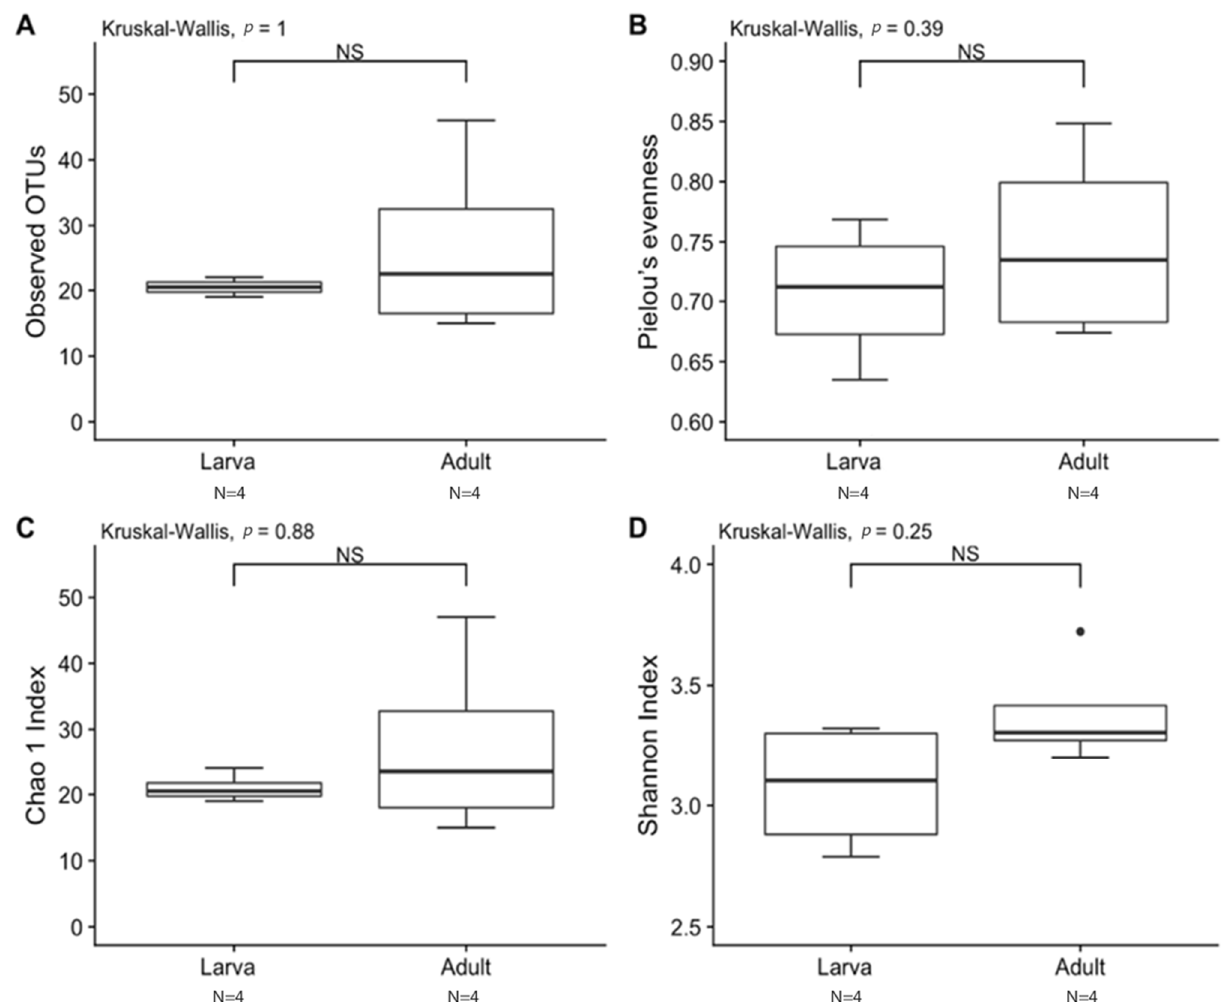
Figure 2. Alpha diversity between laboratory-reared larva and adult T. stercorea gut microbiota. A p -value of ≤ 0.05 was used to indicate significant differences between groups. NS denotes non-significant differences between the groups. N denotes the sample size. ( A ) Species richness boxplot. ( B ) Pielou’s evenness boxplot. ( C ) Chao 1 Index boxplot. ( D ) Shannon Index boxplot. For each group, the bars delineate the means, the hinges represent the lower and upper quartiles, the whiskers extend to the most extreme values, and black dots ( ● ) denote outliers are plotted if present. Table 1. PERMANOVA analysis based on distance matrices between laboratory-reared T. stercorea larvae and adults.